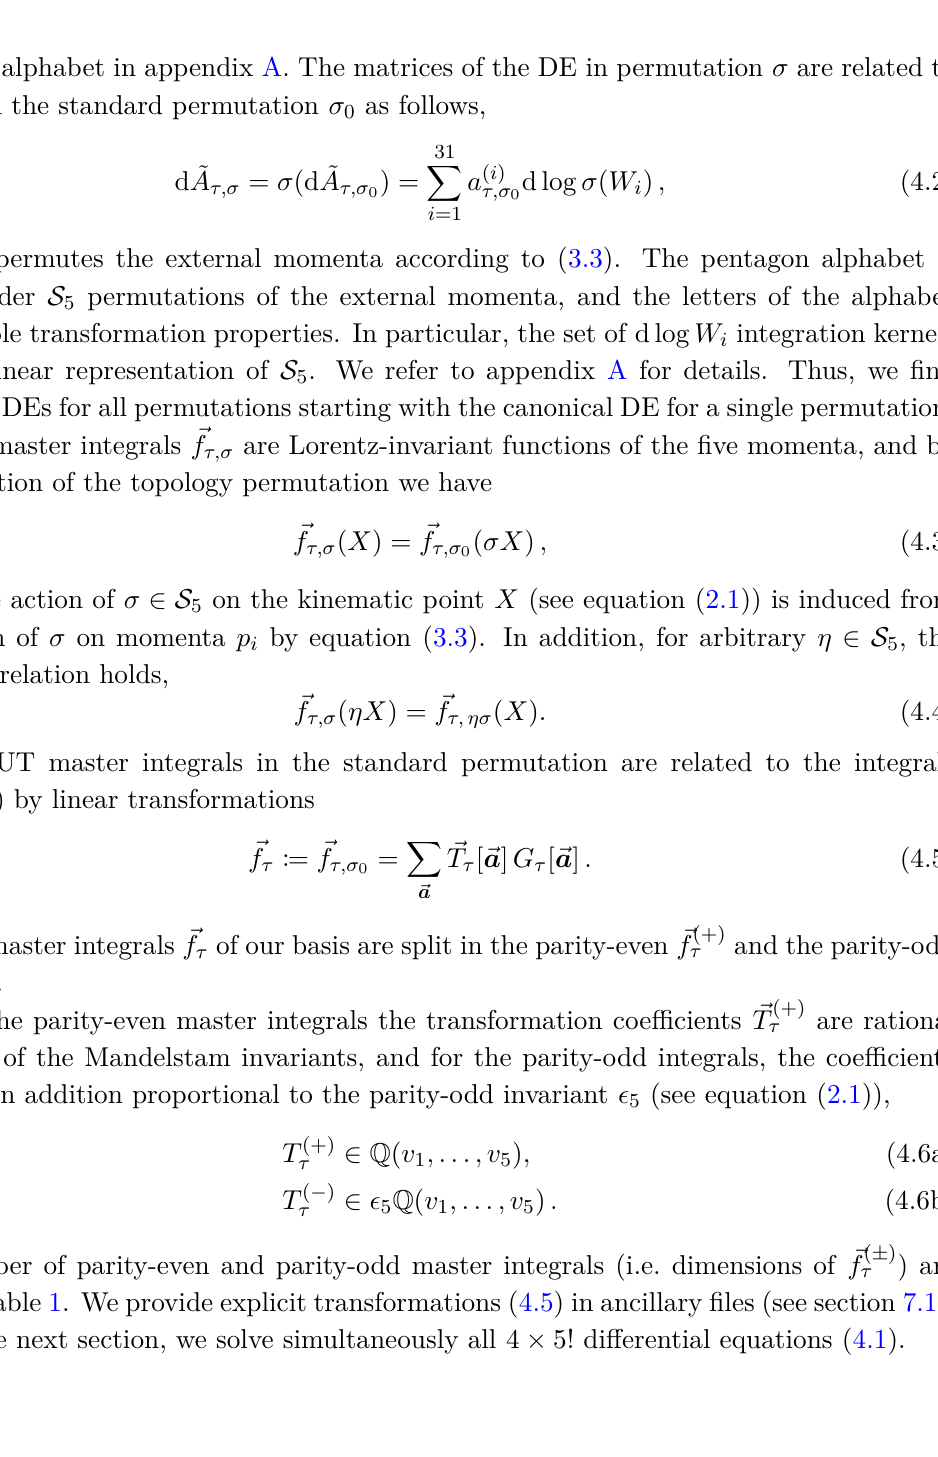
Table 1. Number of parity-even|parity-odd master integrals (a single permutation) in the four integral topologies defined in figure